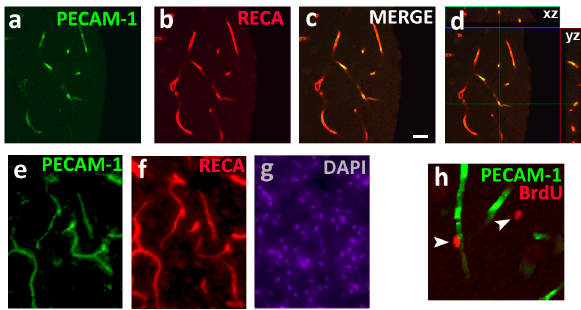
rat endothelial cell antigen (RECA); 1:500 mouse anti-RECA; cyanine 3 (CY3) and 4',6-diamidino-2- phenylindole (DAPI); 1:2000). ( a – d ) Single slice confocal images of PECAM-1 ( a ), RECA ( b ) and merge ( c ); z-scan of the colabeling showing an orthogonal view along the xz and yz axis in ( d ).